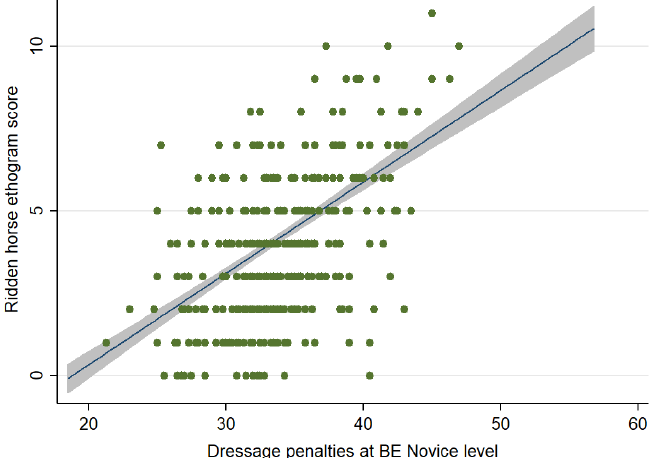
Figure 6. Comparison between the Ridden Horse Pain Ethogram (RHpE) scores and dressage penalty scores for competition starts at British Eventing Novice level ( n = 355; 1 horse was eliminated). The green dots represent individual data points, the blue line is the best linear predicted fit and the grey area represents the corresponding 95% confidence interval. There was a moderate positive correlation (Spearman’s rho = 0.491, p < 0.001) between the RHpE scores and the dressage penalty